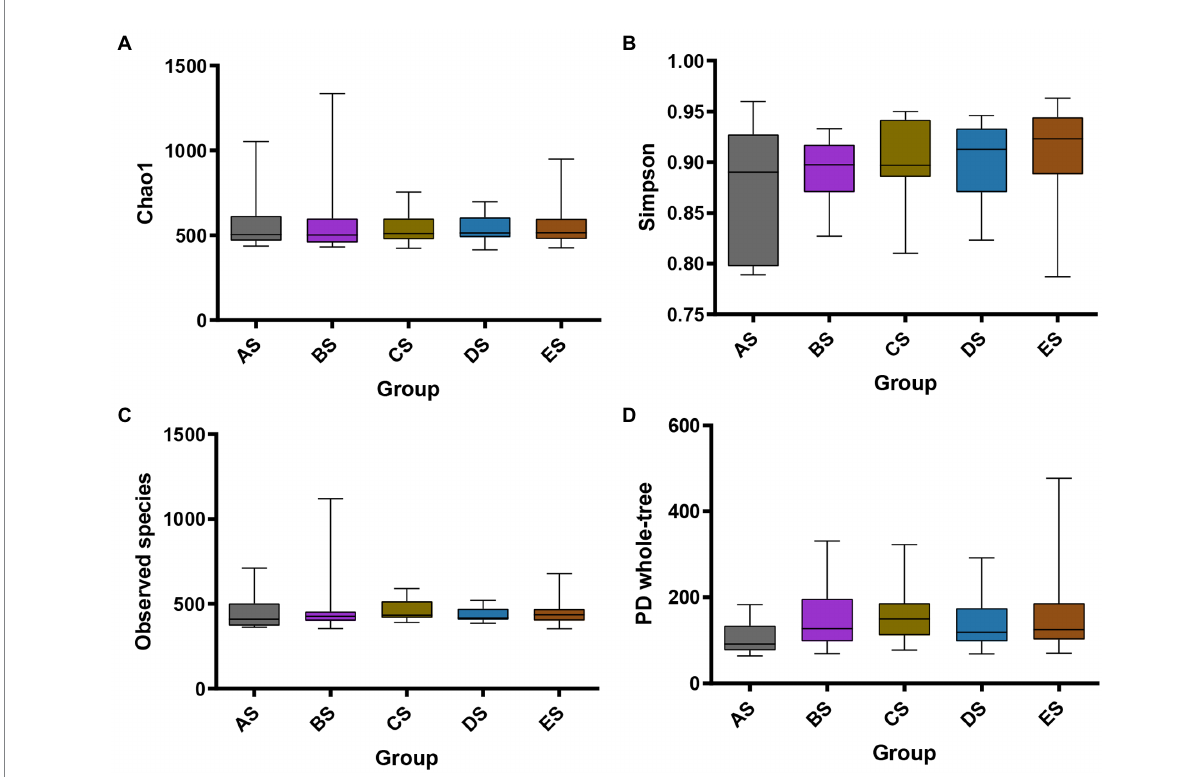
FIGURE 1 Alpha diversity of saliva samples among the five groups. Box plots depict bacterial diversity according to the Chao1 (A) , Simpson (B) , Observed species (C) , and PD whole-tree (D) indices. Statistical analyses were performed using the Friedman test with Dunn’s post-hoc test. There was no statistically significant difference between any two